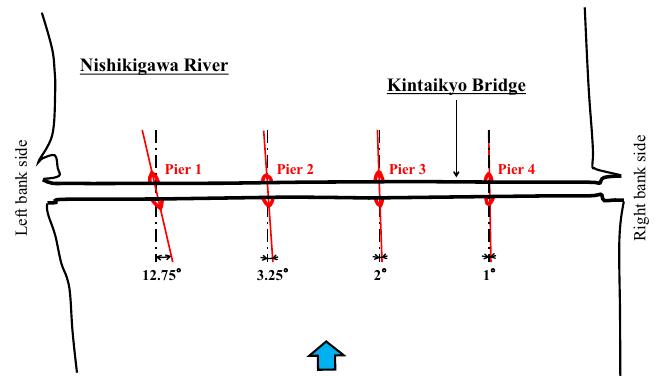
Figure 4. Installation angles of piers prior to loss by flooding in 1950: Redrawn from a figure in Ono 40 .